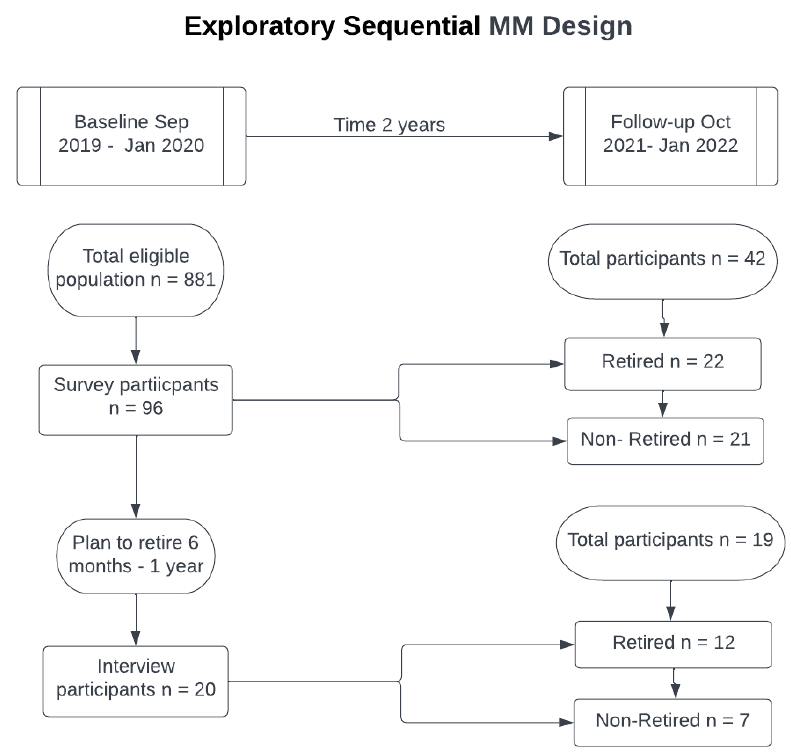
Figure 2. Diagrammatic representation of the adopted MM design.